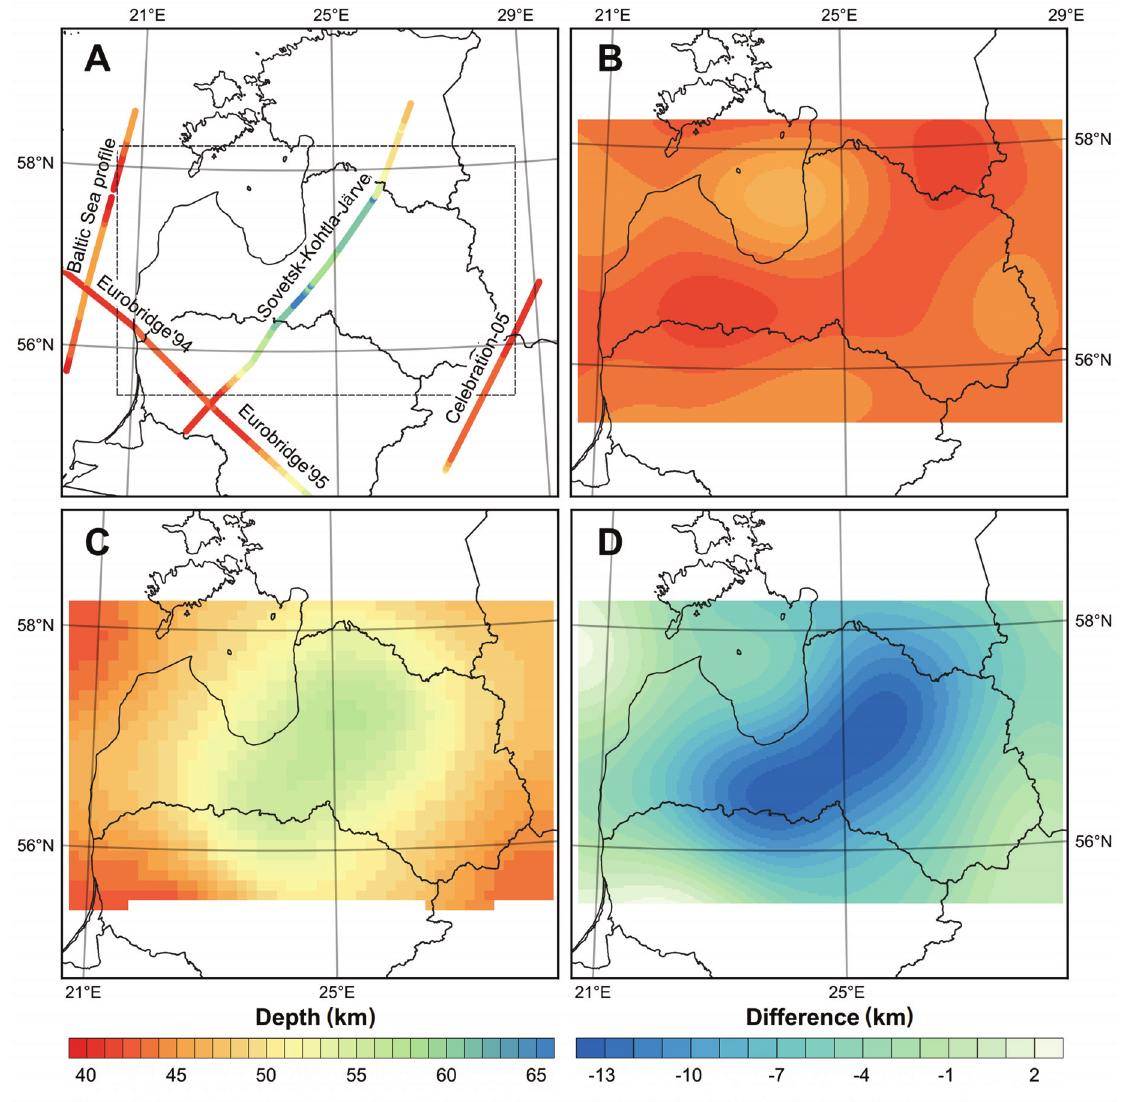
Fig. 4. A , refraction seismic surveys and their respective calculated Moho interface depths in the vicinity of Latvia (digitized from Sadov & Penzina 1986; Ostrovsky et al. 1994; Bogdanova et al. 2006; Grad et al. 2006); B , Moho depth, calculated from the gravity measurements using iterative modelling (the present work); C , subset of the European Moho depth map from Grad et al. (2009); D , difference between the calculated Moho depth and the European Moho depth map from Grad et al. (2009) shown in Fig.